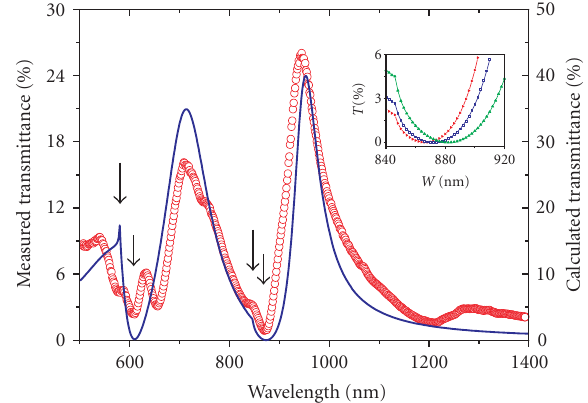
Figure 3: Measured (the open circles) and calculated (the solid line) transmission spectra of gold film perforated with square holes (glass substrate), where the lattice constant is 580nm, the hole side is 265nm, and the film thickness is 220 nm. The longer and shorter arrows correspond, respectively, to the Wood’s anomaly and SPP resonance. The inset shows the evolution of transmission dip (around 870nm) with the permittivity of metal (the solid circles, open squares, and solid triangles are calculated with a permittivity of − 45, − 35, and − 25,